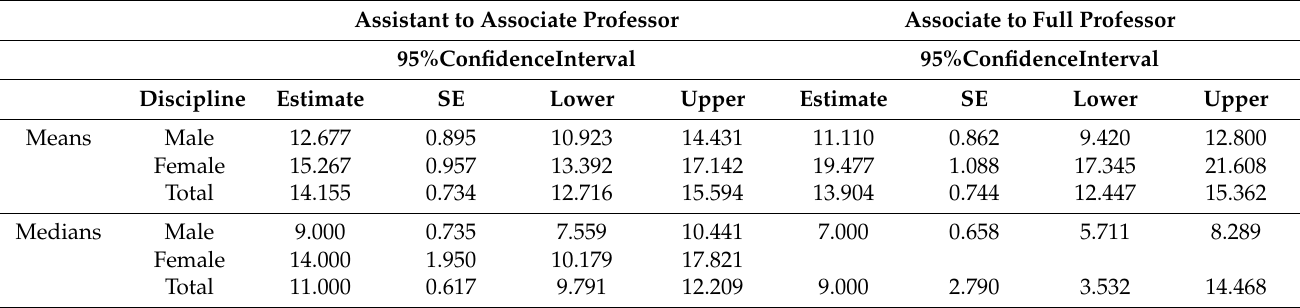
Figure 6. Survival Function for Gender in Promotion from Associate to Full Professor. Figure 5. Survival Function for Gender in Promotion From Assistant to Associate Professor.